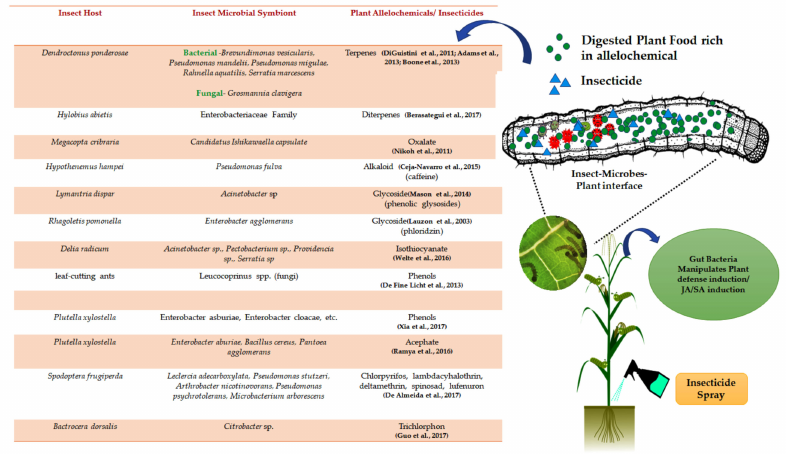
Figure 2. Pictorial representation of the insect–microbes–plant interface inside the gut of phy- tophagous insects. Insect-associated microbes manipulate host plant defence induction and metabolise/detoxify phytotoxins. Insect mutualists also detoxify insecticides and enhance the host